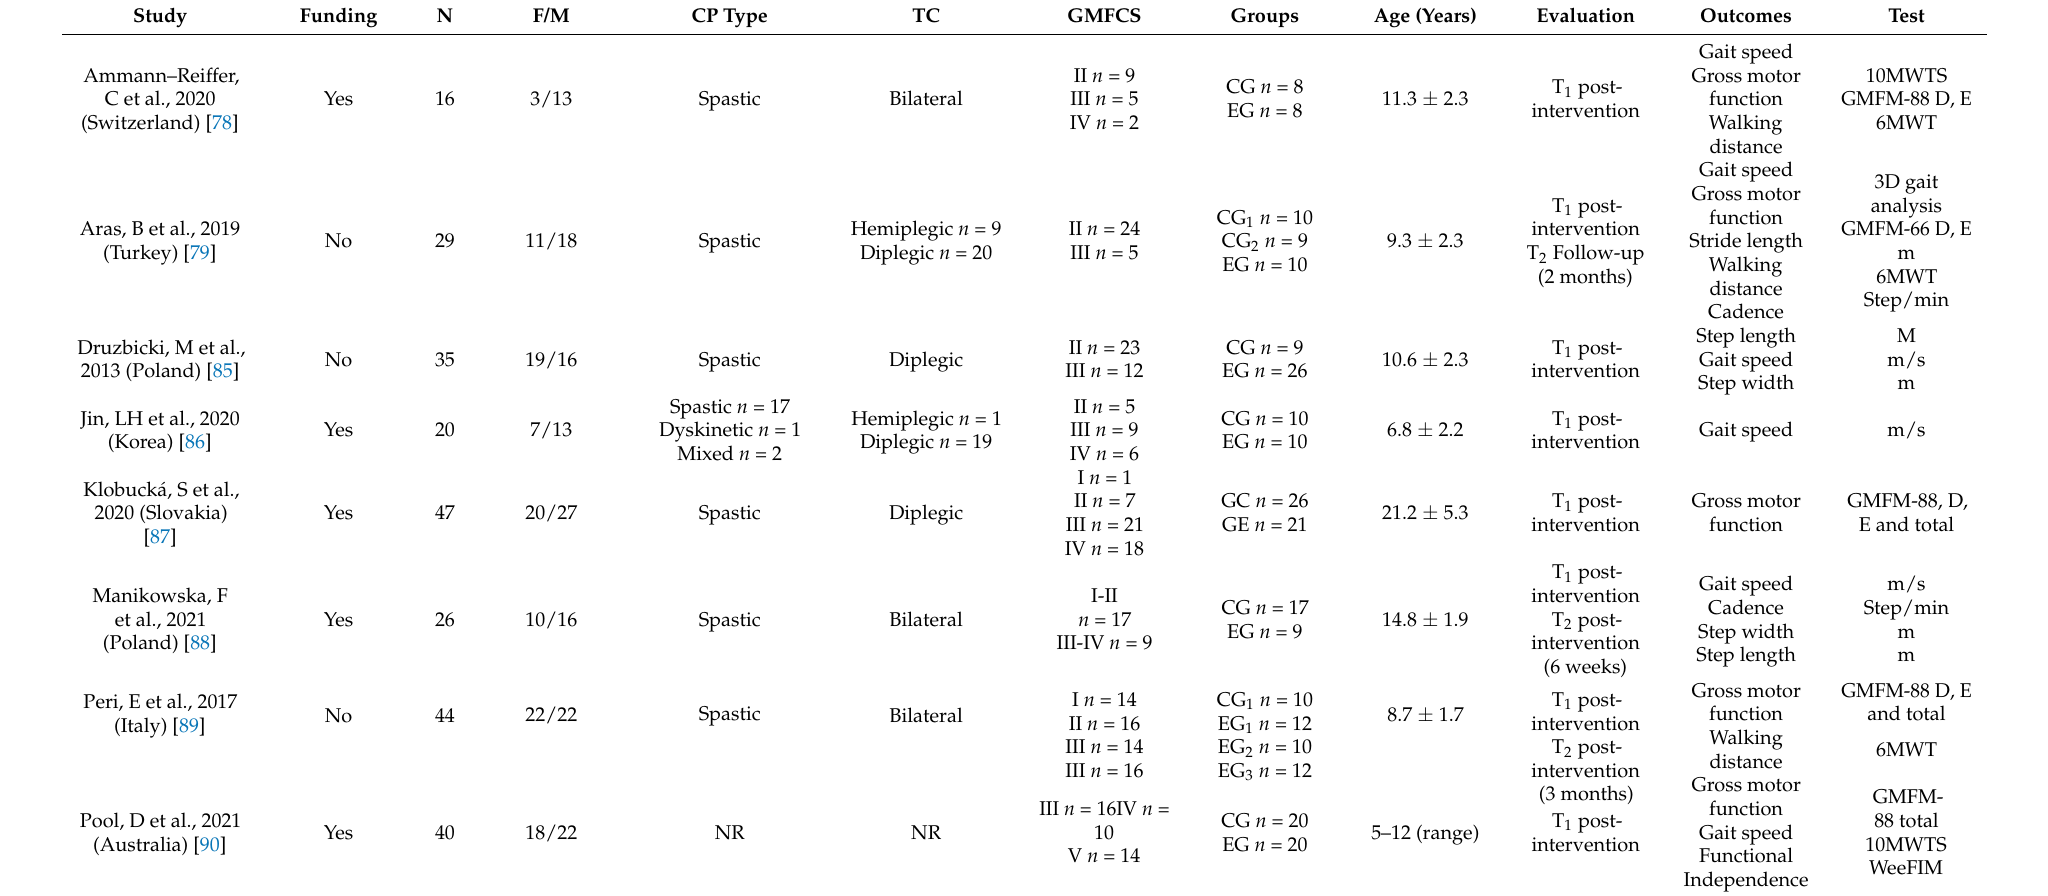
Table 2. Characteristics of the studies included in the systematic review and